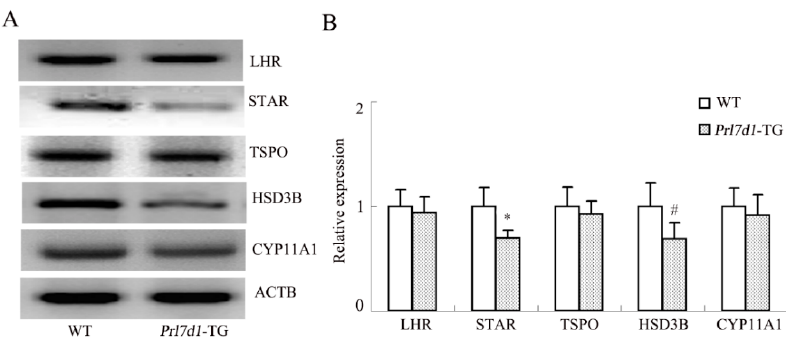
Figure 5. Western blot analyses of the LHR, STAR, TSPO, HSD3B and CYP11A1 in the testes of wild-type (WT) and Prl7d1 transgenic ( Prl7d1 -TG) mice. ( A ) Representative Western immunoblots;